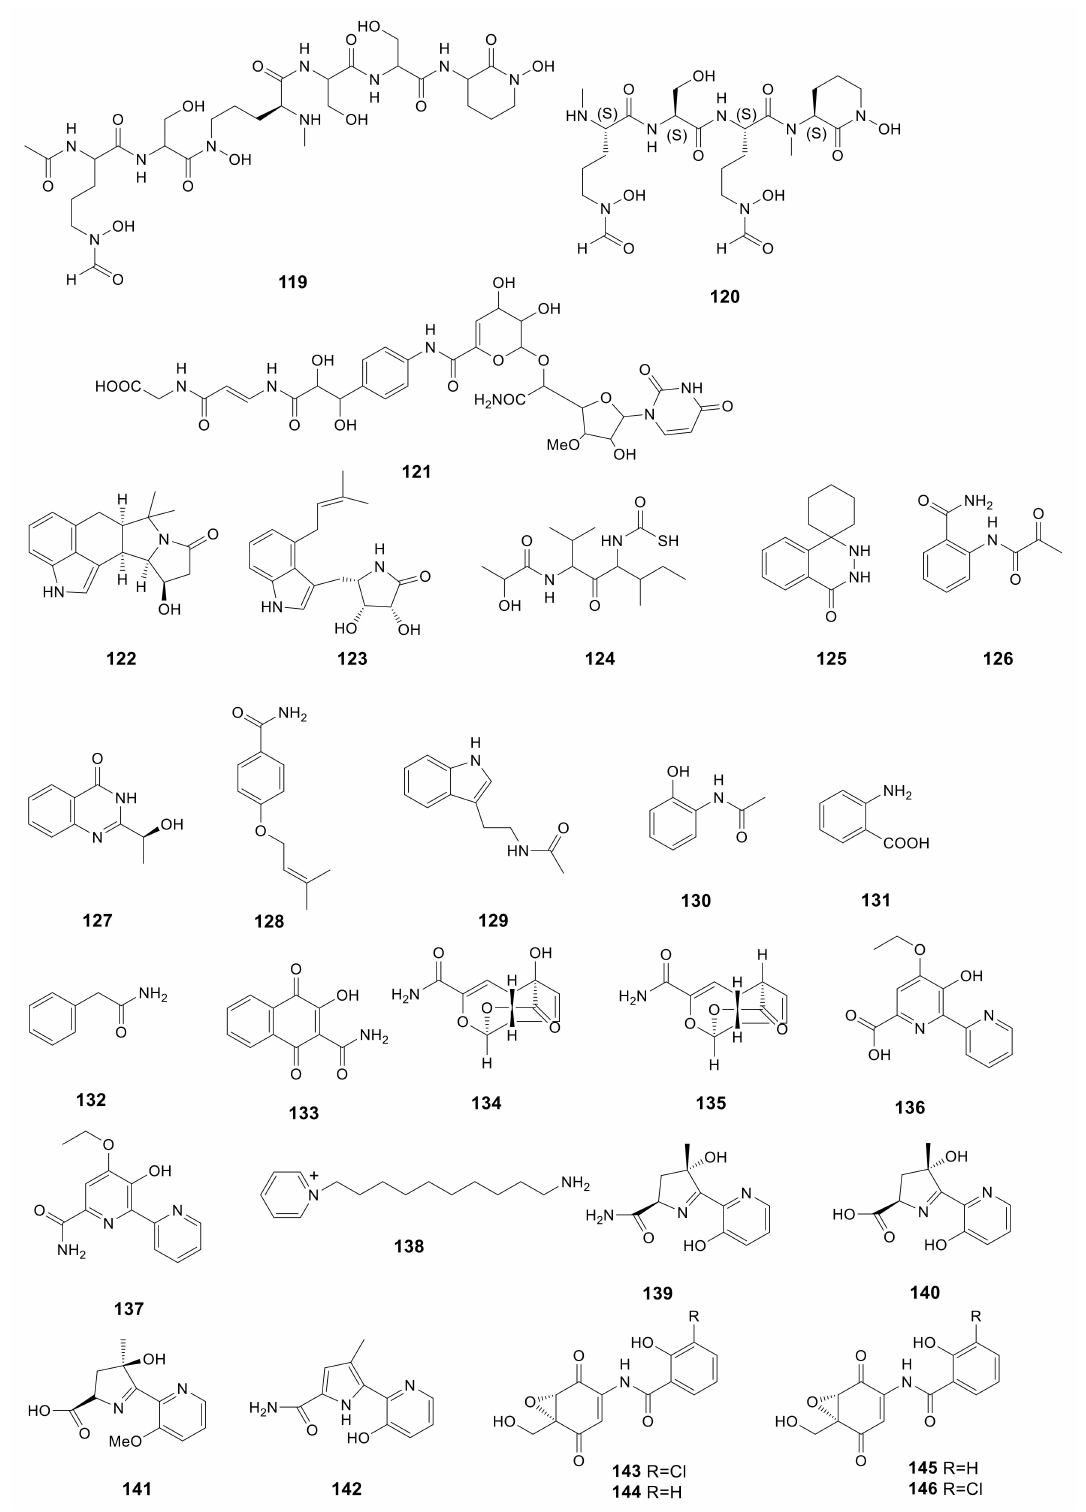
Figure 6. Structures of amide derivatives ( 119 – 146 ) from Amycolatopsis .